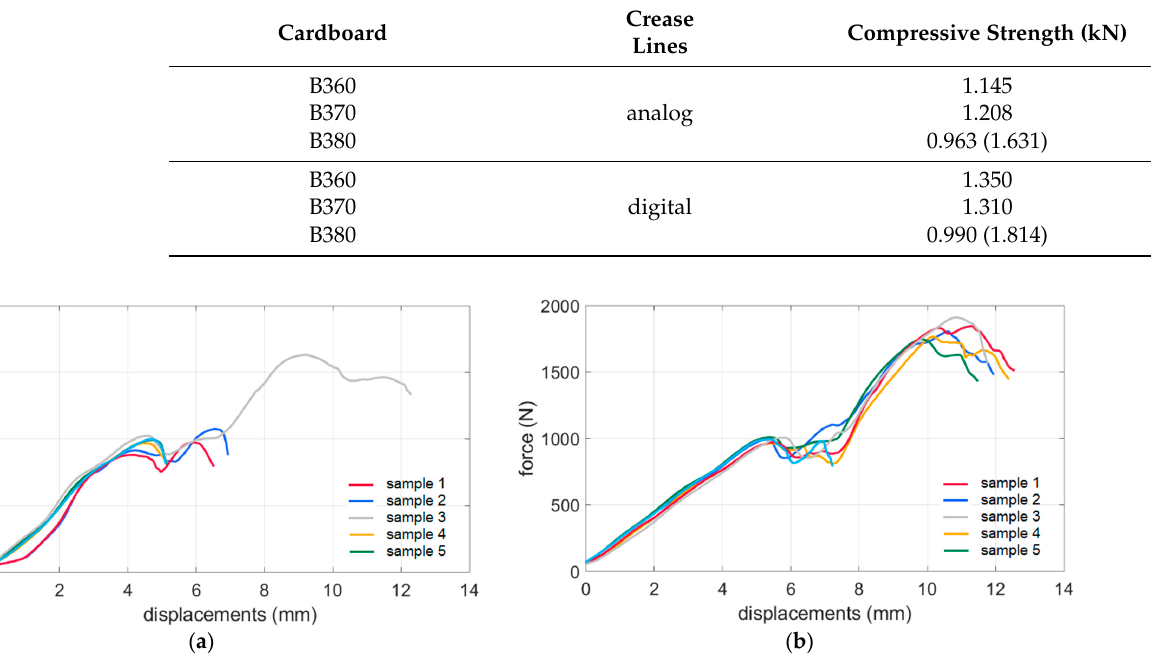
Figure 11. Box compression test results from six samples of B380 corrugated board for each production technology: ( a ) analog and ( b ) digital crease lines.